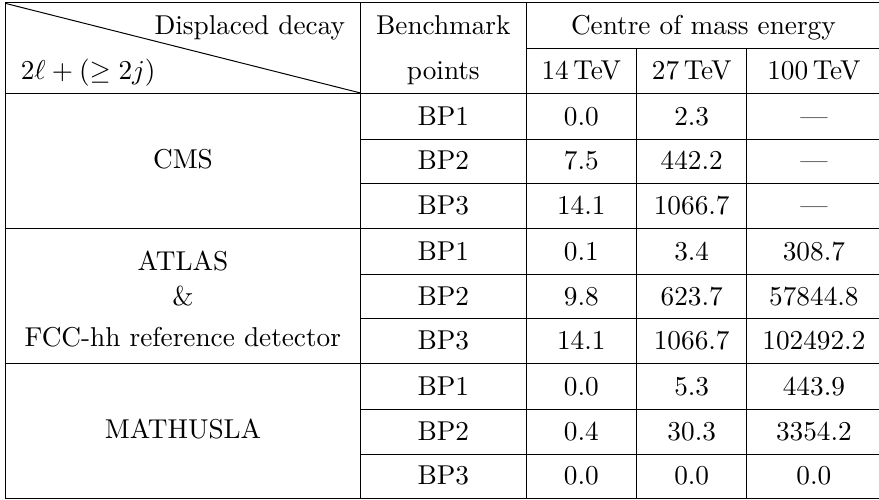
Table 10. Number of events in 2 ‘ + ( ≥ 2 j ) final state for the benchmark points with the center of mass energies of 14 TeV, 27 TeV and 100 TeV at the integrated luminosities of 3 ab − 1 , 10 ab − 1 and 30 ab − 1 , respectively. The numbers are given separately for CMS, ATLAS, FCC-hh reference detector (for 100 TeV) and